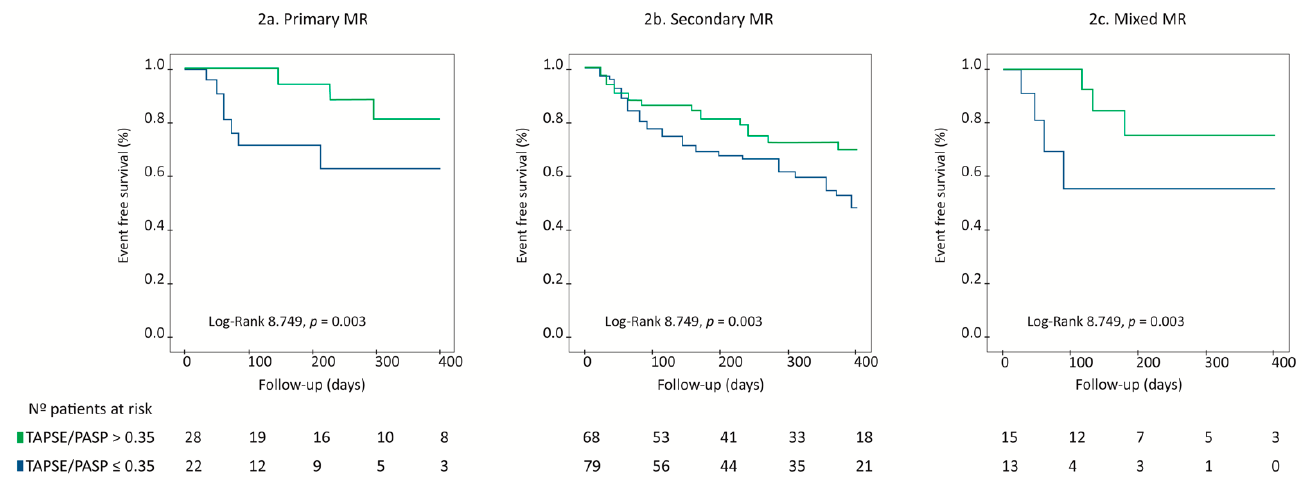
Figure 2. Survival analysis according to TAPSE/PASP ratio as shown by Kaplan–Meier curves, stratified according to MR aetiology. TAPSE/PASP ratio ≤ 0.35 is associated with higher rates of the primary combined endpoint in patients with primary MR ( a ), secondary MR ( b ) and mixed MR ( c ).